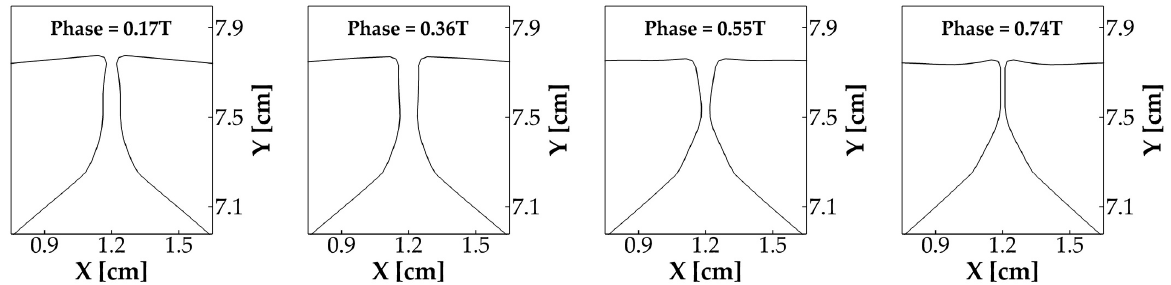
Figure 5. The vibration pattern of the vocal folds in the baseline case, shown by the mid-coronal profile of the vocal folds at four different time instants over one vibration cycle.